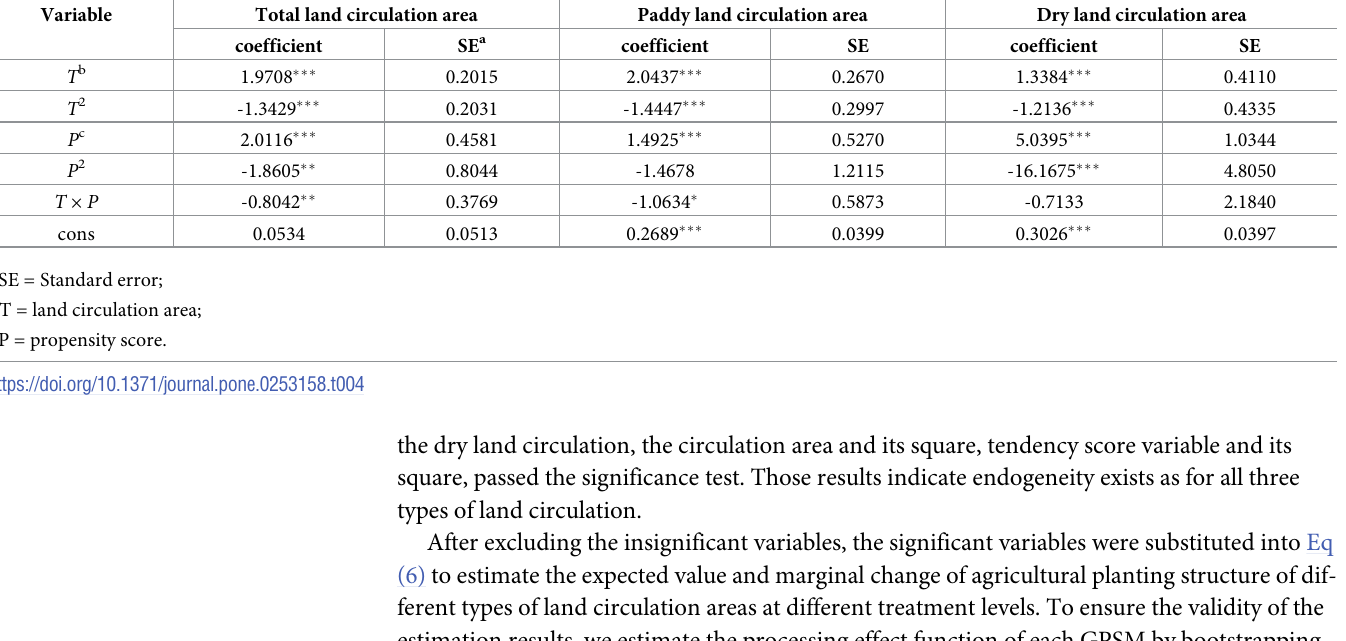
Table 4. Second-order approximation estimation results for agricultural planting structure. Variable